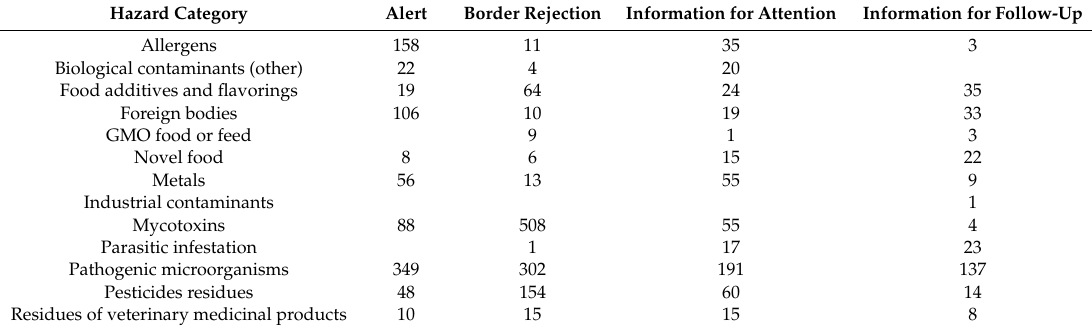
Table 3. Notifications by hazard category in the EU in 2018 (RASFF, Annual Report, 2018) [32]. GMO—genetically modified